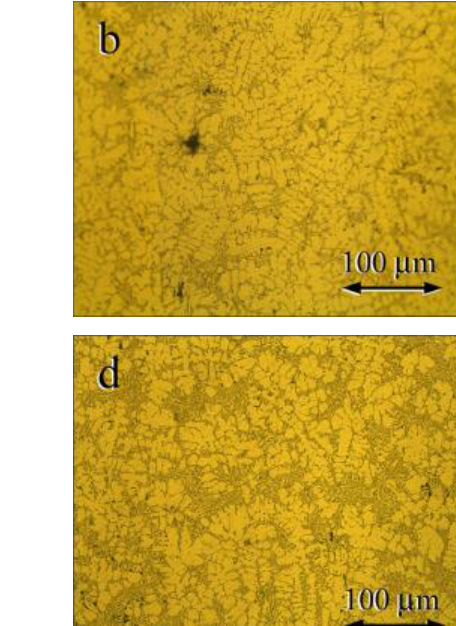
Figure 7. Microstructures of the as-cast Al-10 Si wt.% alloys with the following B contents: ( a ) 0.01 wt.%; ( b ) 0.02 wt.%; ( c ) 0.03 wt.%; and ( d ) 0.05 wt.%.